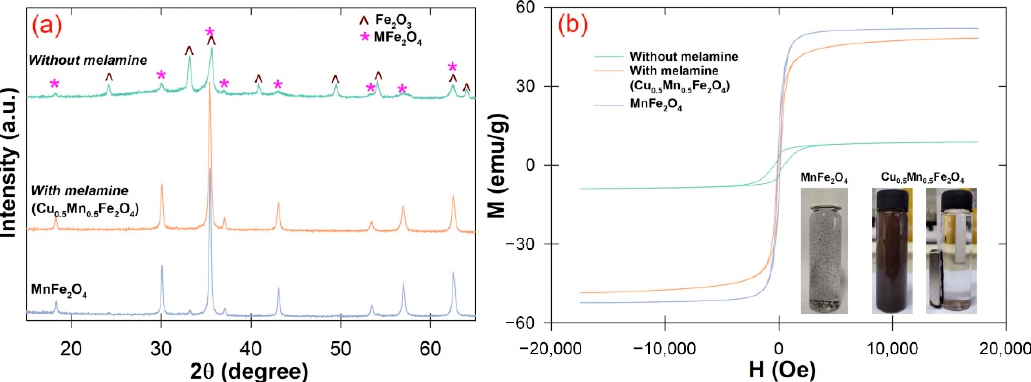
Figure 1. The prepared catalysts: ( a ) XRD, and ( b ) VSM (inset photo illustrated the magnetic separation).